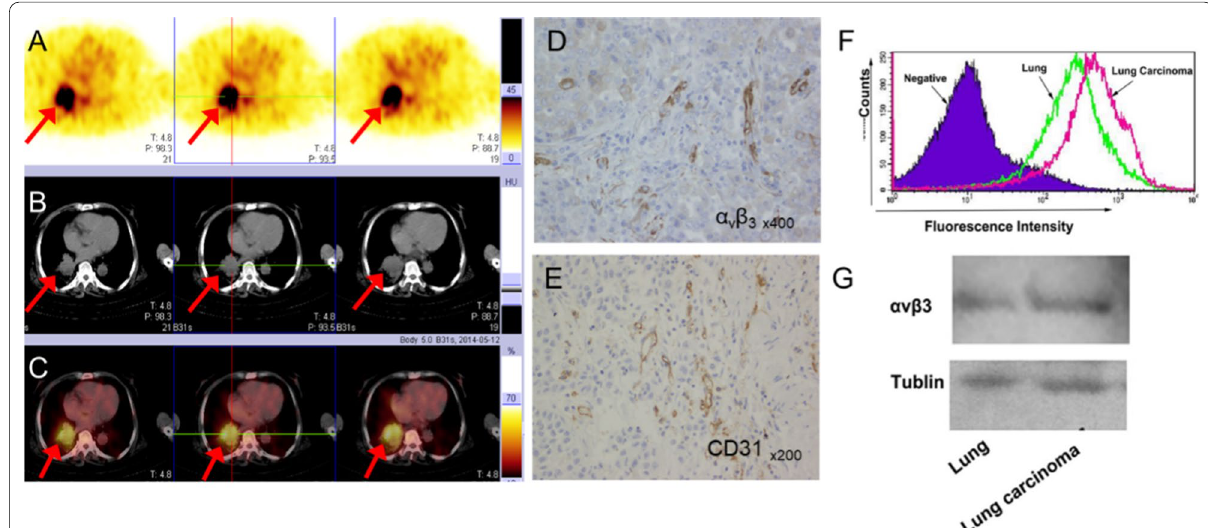
Fig. 9 RGD-avid lesion in a patient with lung adenocarcinoma, consistent with α v β 3 expression which confirmed by IHC, flow cytometry and western blot. a – c [ 99m Tc]Tc-Galacto-RGD 2 image. d , e IHC showed higher expression of α v β 3 in the tumour cells and higher density of micro-vessel (CD31). f Flow cytometry showed higher expression of integrin β 3 in tumour tissue compared with normal lung tissue. g Western blot showed higher integrin β 3 expression in primary tumour tissue compared with normal lung